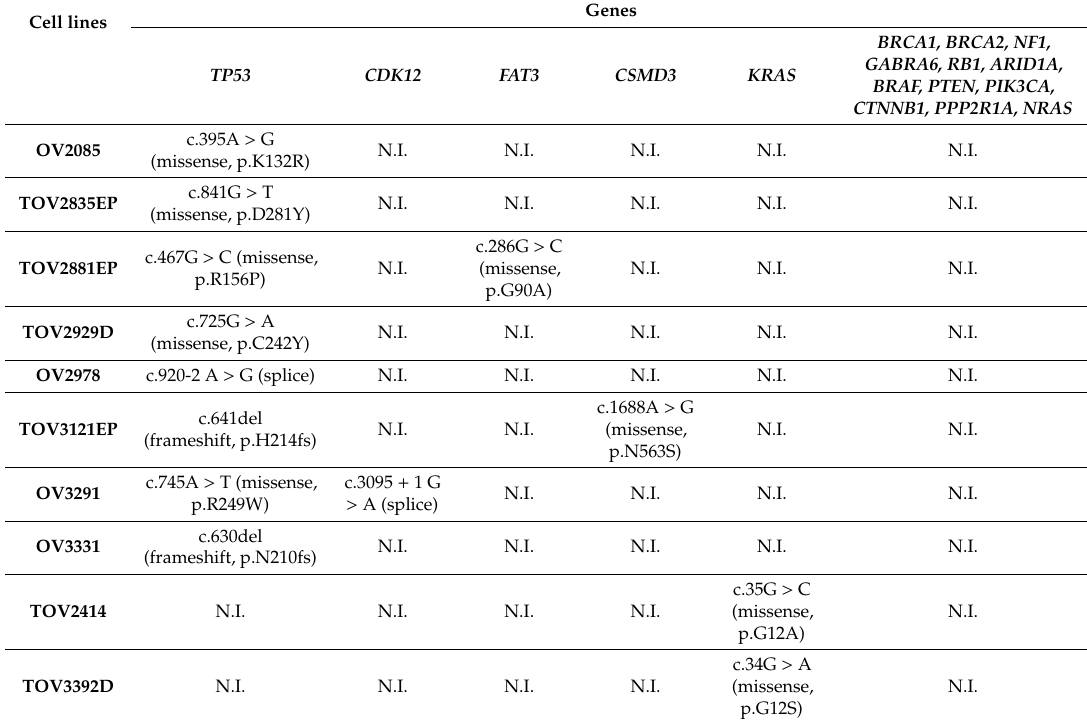
Table 3. Profiling of deleterious homozygous mutations by whole exome sequencing and mutation analysis of EOC subtype-specific candidate genes in the derived EOC cell lines. Genes Cell lines TP53 CDK12 FAT3